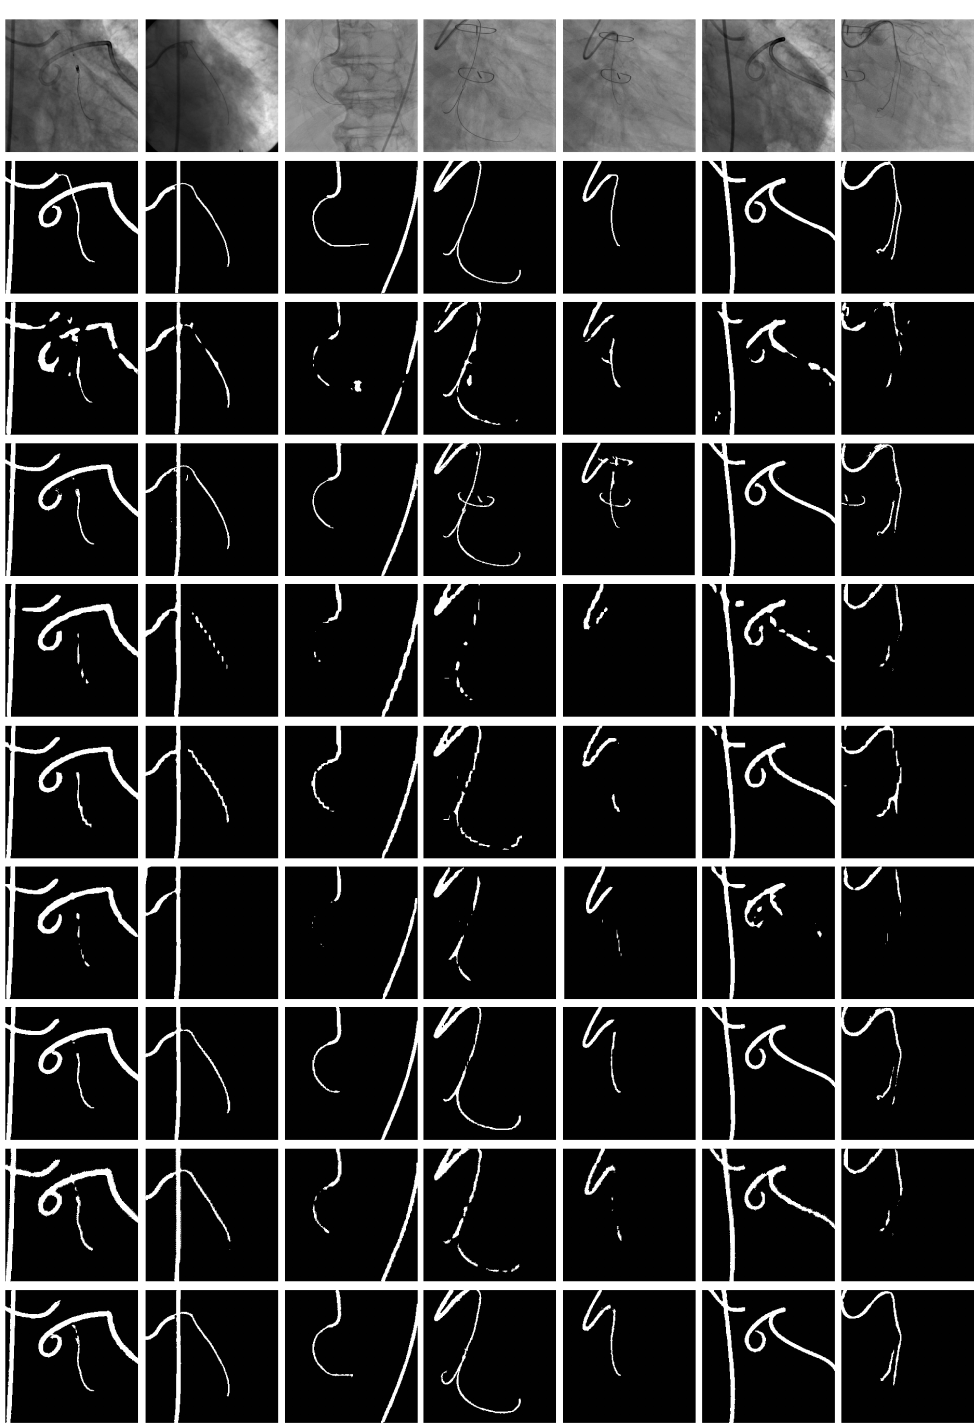
Figure 7. Test image results of a segmentation models trained with 30,000 generated images. From top to bottom: input (1st row), the label images (2nd row), U-Net [26] trained with 140 labeled images (3rd row), U-Net [26] trained with 30,000 generated images (4th row), PSPNet [43] trained with 140 labeled images (5th row), PSPNet [43] trained with 30,000 generated images (6th row),PAN [44] trained with 140 labeled images (7th row), PAN [44] trained with 30,000 generated images (8th row), Linknet [42] trained with 140 labeled images, (9th row), and Linknet [42] trained with 30,000 generated images (10th